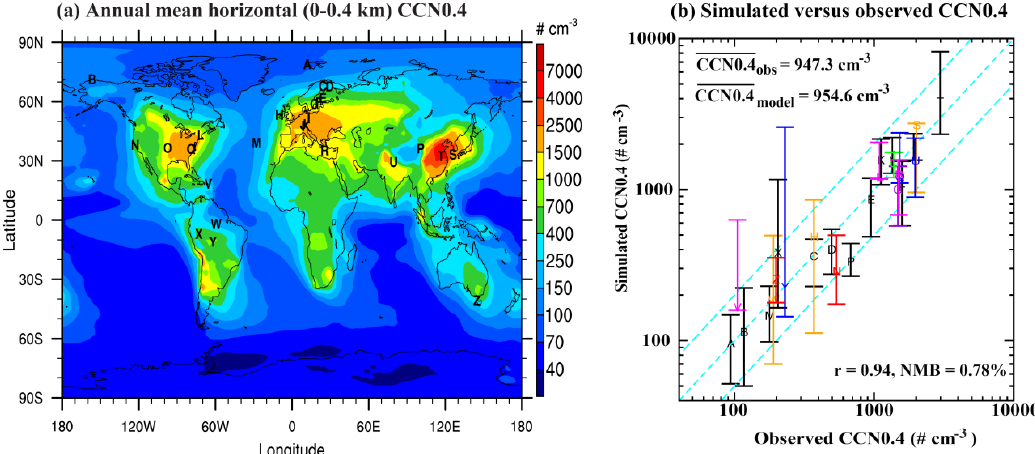
Fig. 5. (a) Simulated global distribution of CCN concentrations (annual mean number concentration for CCN that are active at a water supersaturation of 0.4%) averaged within the lower boundary layer (0–0.4km) (designated as [CCN0.4] LBL ) . (b) Comparison of simulated [CCN0.4] LBL with observed values at 26 sites around the globe (locations are indicated in Fig. 5a by letters). In Fig. 5b, model results correspond to the months of the observations, and vertical bars define the simulated ranges of monthly mean CCN0.4 values. In Fig. 5b, the site identifier and bars indicating variance are color coded for